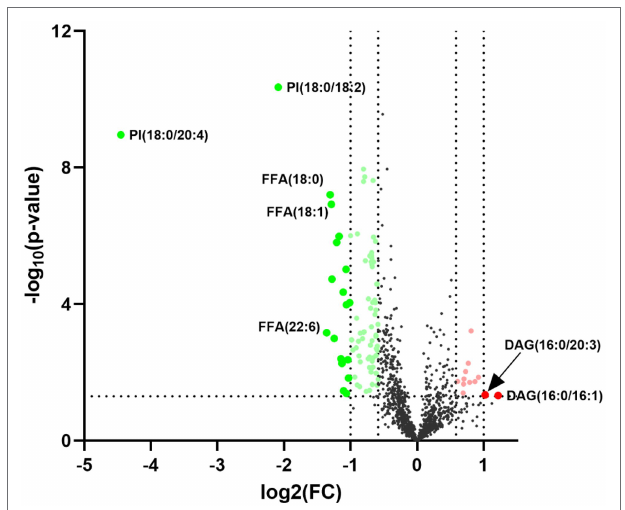
FIGURE 1 | Volcano plot for the 21 lipid molecules showing statistically significantly different levels between nasopharyngeal carcinoma (NPC) patients and controls. The x -axis shows Log 2 (FC), the y -axis shows –Log 10 ( p value) and each dot represents one lipid. The big red and green dots above the straight line [ − Log 10 (0.05)] show lipids with statistically significantly different levels between NPC patients and controls as well as a fold-change (FC) greater than 2 (alternatively smaller than 0.5). PI, phosphatidylinositol; FFA, free fatty acid; DAG,